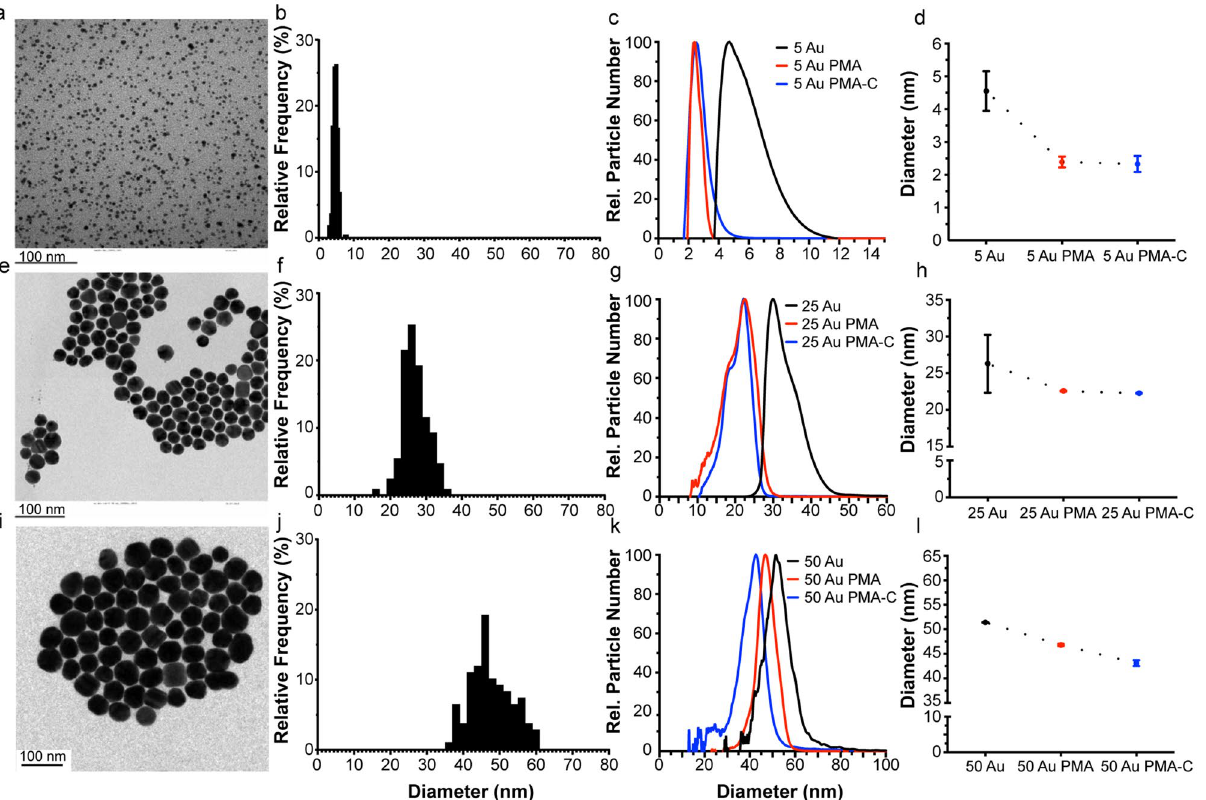
Figure 1. Characterisation of PMA coated AuNPs of different sizes by TEM and DCS. Measurements for 5, 25 and 50 AuNPs are shown respectively in the top ( a – d ), middle ( e – h ) and bottom ( i – l ) panels. TEM measurements were performed on the polymer-coated NPs. Representative micrographs for each of the different sizes ( a , e , i ) and the resulting histogram counts ( b , f , j ) are provided with average core diameters of 4.8 ± 0.7, 26.9 ± 3.4 and 47.6 ± 5.7 nm respectively. DCS measurements were performed for the three relevant NP suspensions, i.e. AuNPs in the organic solvent (toluene) prior to PMA coating (black line), the Au-PMA polymer-coated NPs after water transfer (red line) and Au-PMA-Corona complexes in situ measured after corona formation (blue line). Representative DCS distributions are provided for each of the NP sizes ( c , g , k ) along with the detailed average and standard deviations across independent replicates ( d , h , l ). Particle diameters obtained from DCS measurements assumed a particle density of 19.3 g cm -3 .